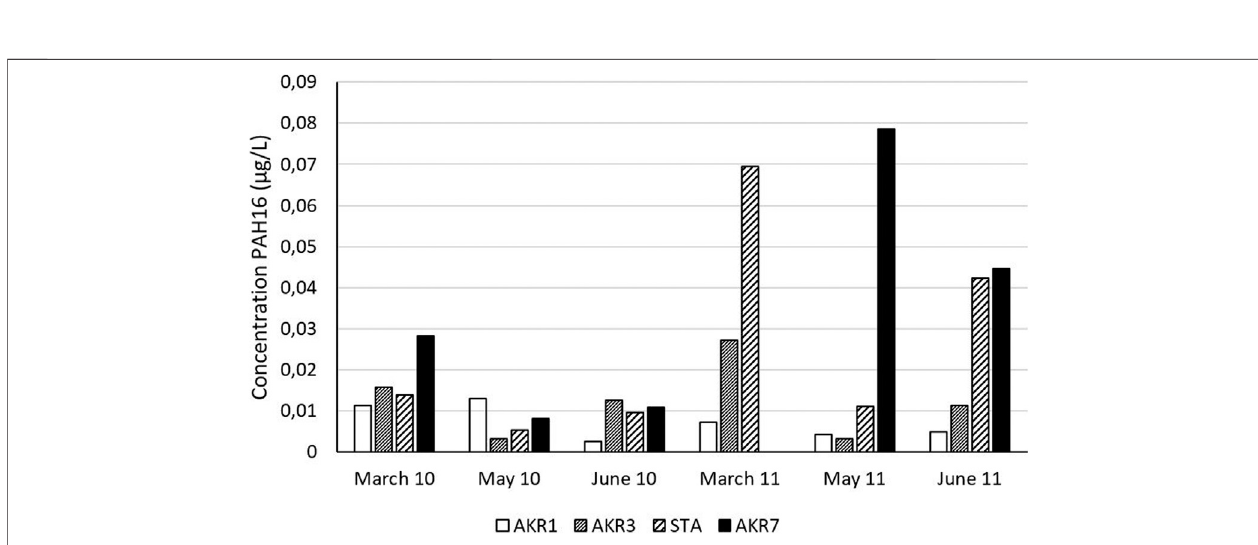
FIGURE 3 | Aluminum normalized concentrations of Pb and Cd measured in the weekly time-composite samples.